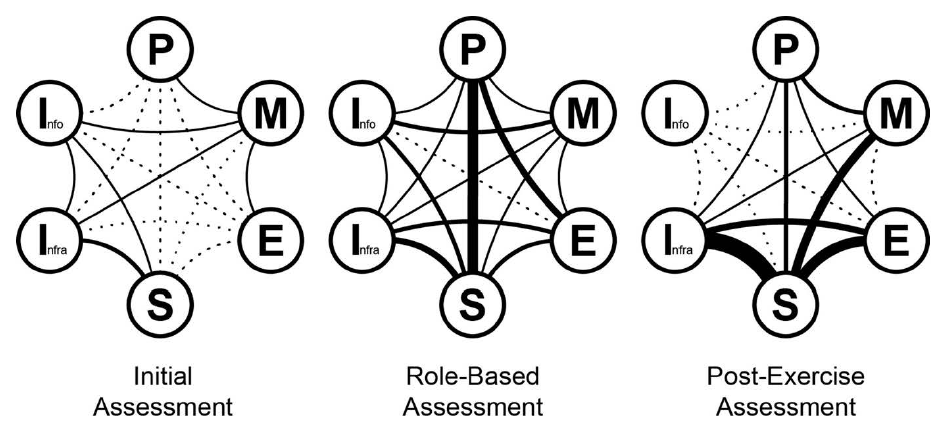
Comparison of most identified critical uncertainty relationships (Source: Author,